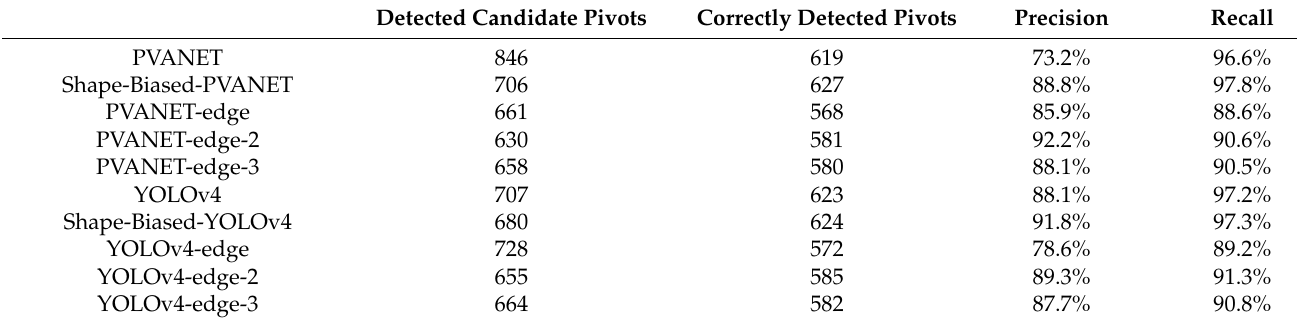
Table 4. The results of PVANET and YOLOv4 with only edge image samples in the training